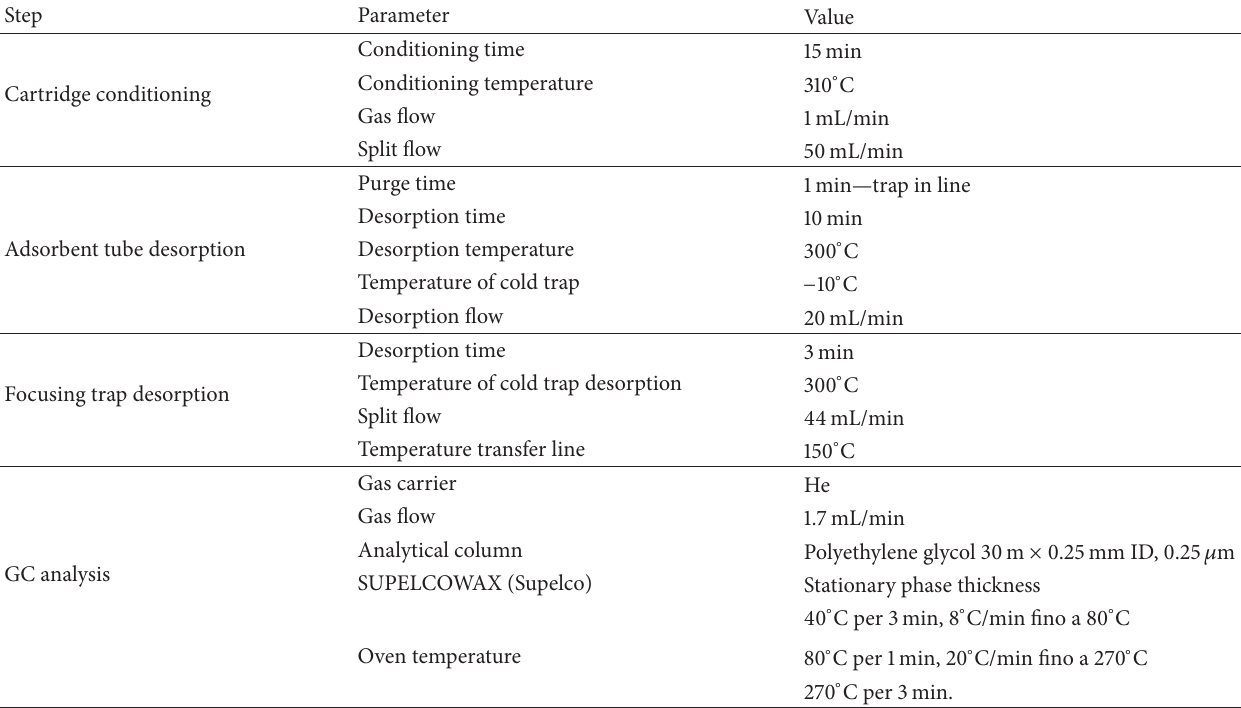
Table 1: Annual mean concentrations of the investigated pollutants in each sampling sites expressed as 𝜇 g/m 3 . Step Cartridge conditioning